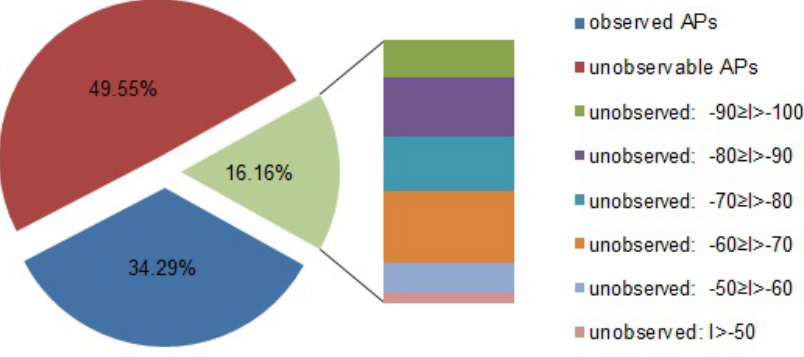
Figure 3. Proportion of the observed APs, the unobservable APs and the missed APs. Here, I is referred to as the theoretical RSS, which is an average value from the records in which this AP is observed.